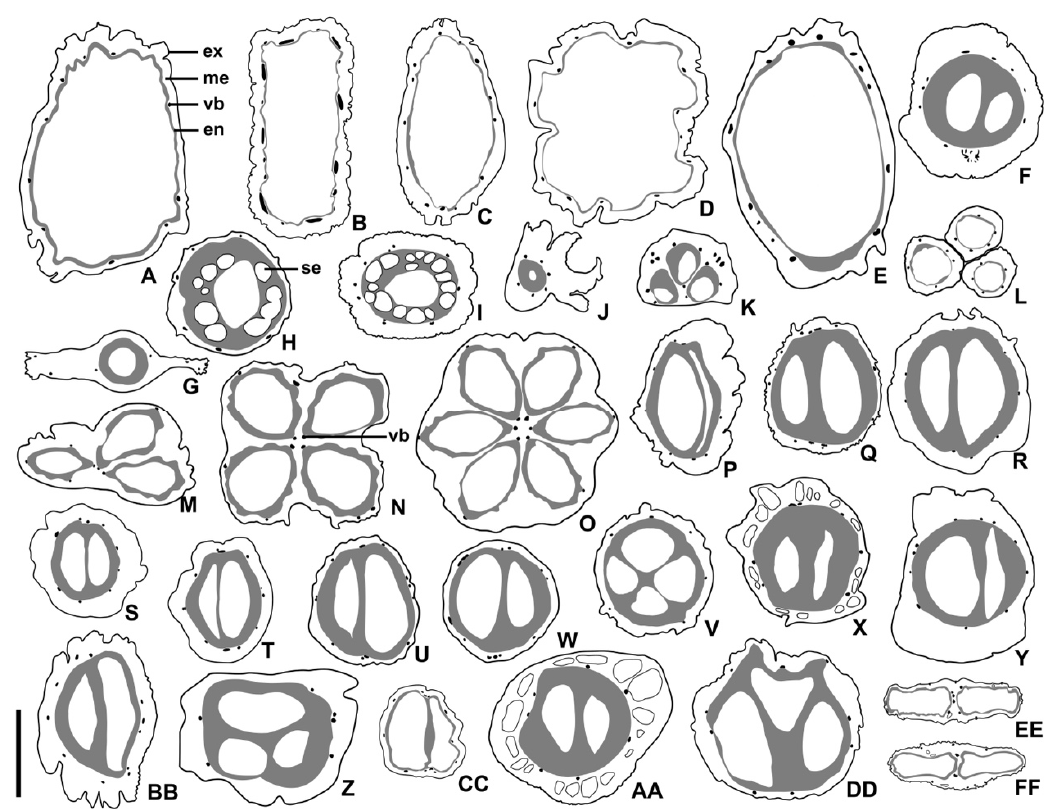
Figure 4. Simplified illustrations of pericarp structures. ( A ) Aucuba chinensis var. angusta; ( B ) A. chinensis; ( C ) A. himalaica var. dolichophylla; ( D ) A. japonica; ( E ) A. obcordate; ( F ) Cornus controversa; ( G ) C. canadensis; ( H ) C. chinensis; ( I ) C. officinalis; ( J ) C. elliptica; ( K ) C. capitata; ( L ) C. hongkongensis; ( M ) Helwingia chinensis; ( N ) H. japonica; ( O ) H. omeiensis; ( P ) Cornus alba; ( Q ) C. alsophila; ( R ) C. bretschneideri; ( S ) C. hemsleyi; ( T ) C. koehneana; ( U ) C. macrophylla; ( V ) C. oblonga; ( W ) C. quinquenervis; ( X ) C. poliophylla; ( Y ) C. sanguinea; ( Z ) C. schindleri; ( AA ) C. ulotricha; ( BB ) C. walter; ( CC ) C. wilsoniana; ( DD ) Torricellia angulate; ( EE ) Heteropanax brevipedicellatus; ( FF ) Kalopanax septemlobus; ex = exocarp, me = mesocarp, vb = vascular bundle, en = endocarp, se = secretary cavity; scale bars = 3 mm in ( A – I , M – X ); 2 mm in ( J – L , EE , FF ); and 4 mm in ( Y – DD ).